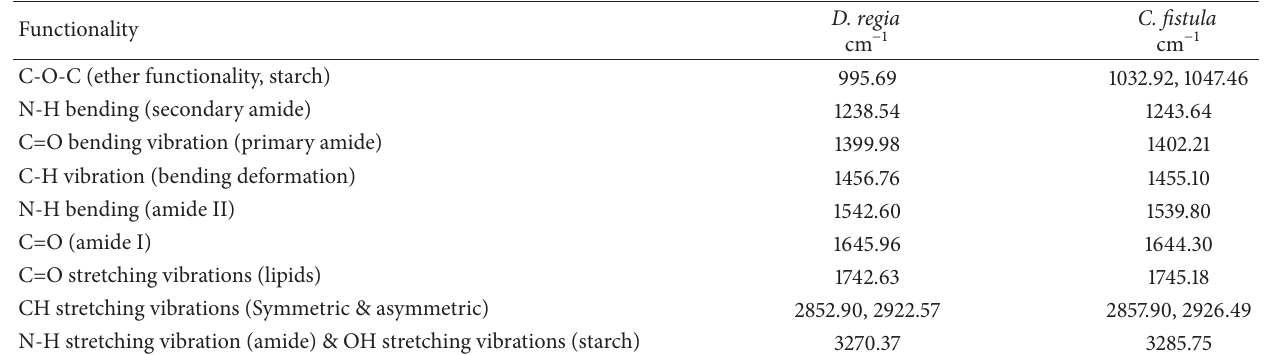
Table 6: FTIR spectroscopic data of seed samples of D. regia and C. fistula .